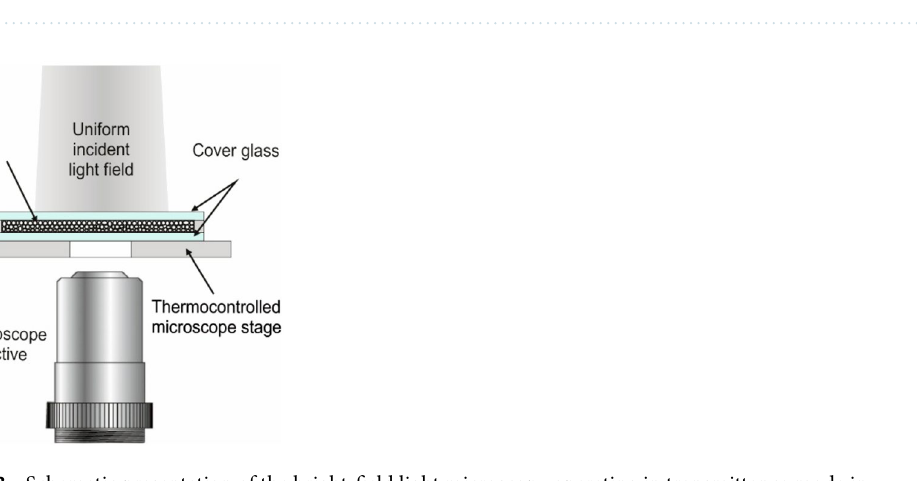
Figure 3. Schematic presentation of the bright-field light microscopy operating in transmittance mode in experimental measurements of adipose